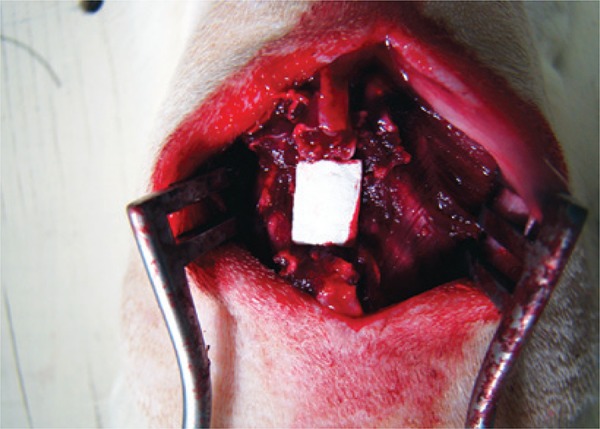
Colocação da tela de silicone sobre a lesão da medula espinal